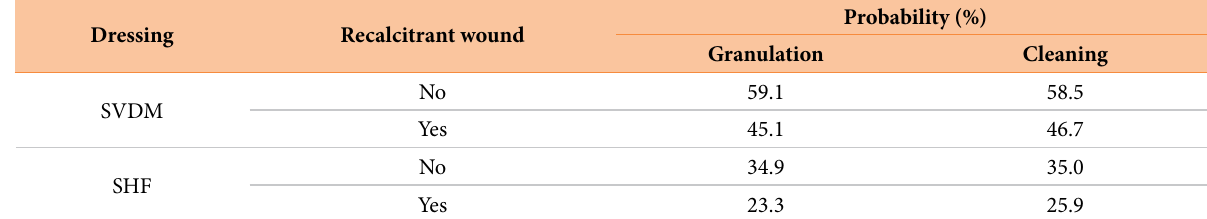
Table 5 - Probability of success (obtained from the Poisson model) in granulation and wound cleaning according to the combination of dressings and wound